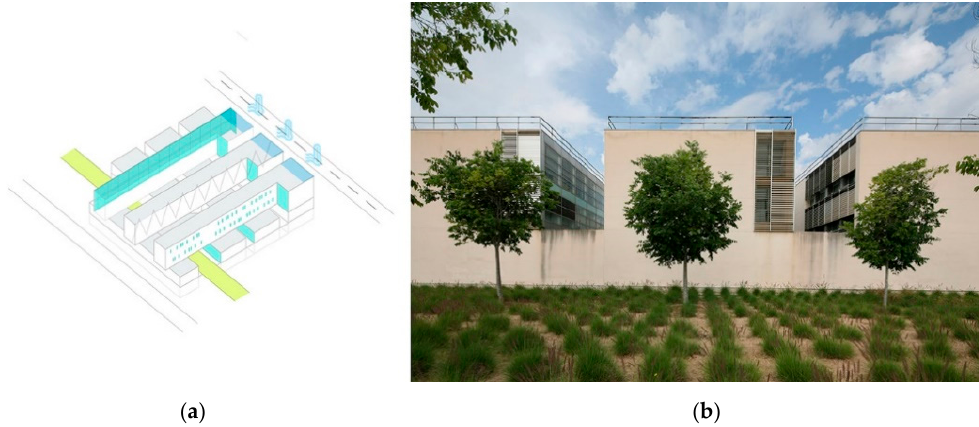
Figure 10. HPS IV: Materiality scheme ( a ) and north facade ( b ). Drawing: Carlos Pastor García. Photo: Courtesy of UA’s Technical Office.